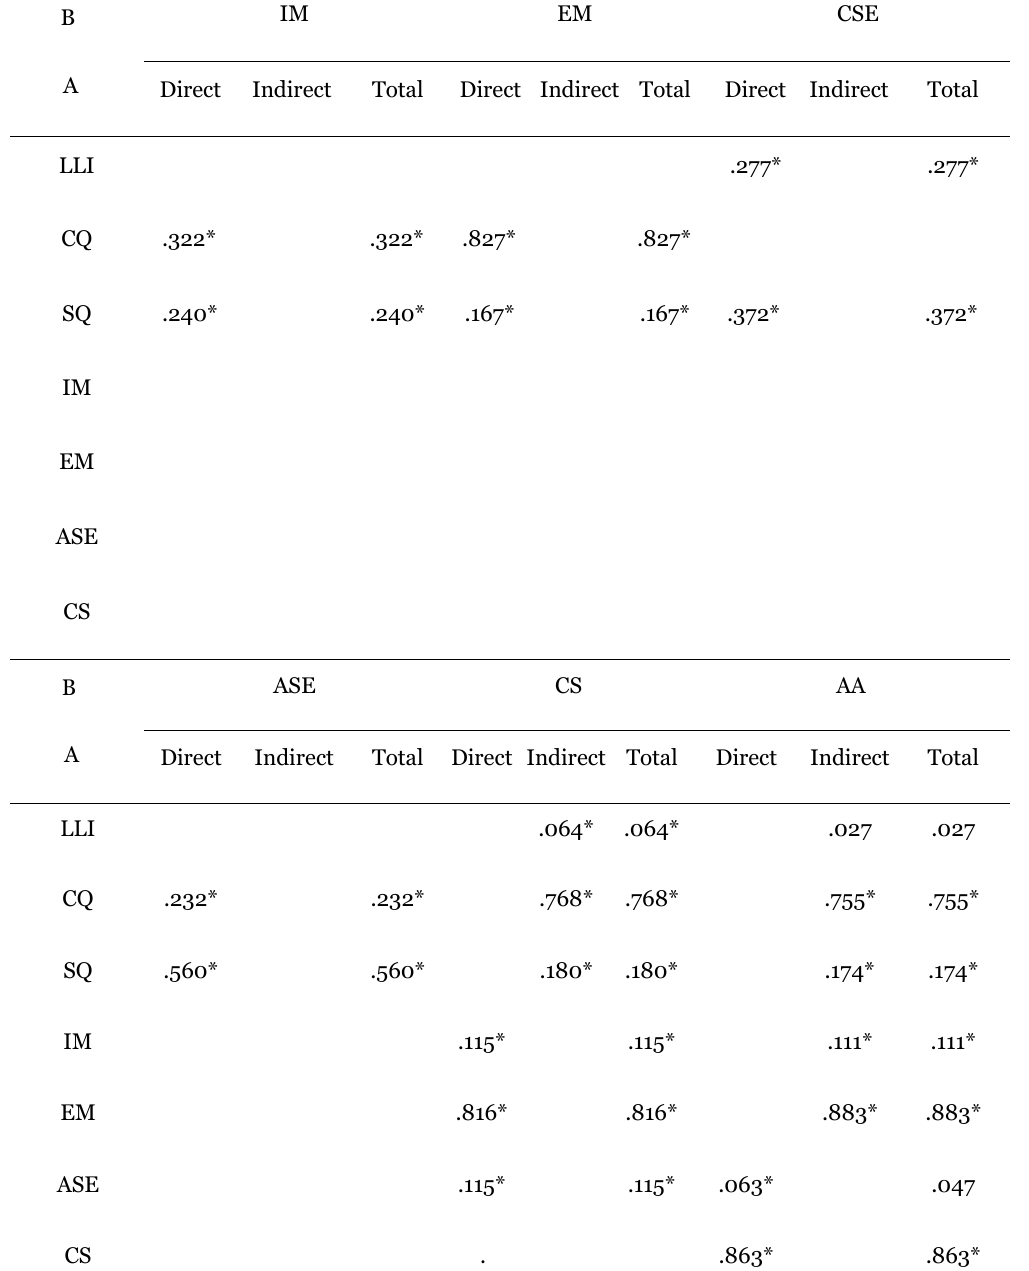
Direct, Indirect, and Total Effects for the Research Model